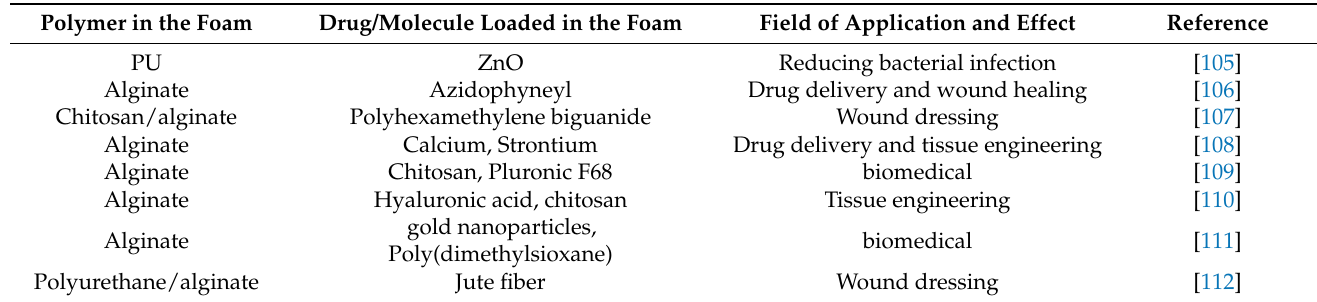
Table 3. Drugs loaded in foams for wound treatment and their